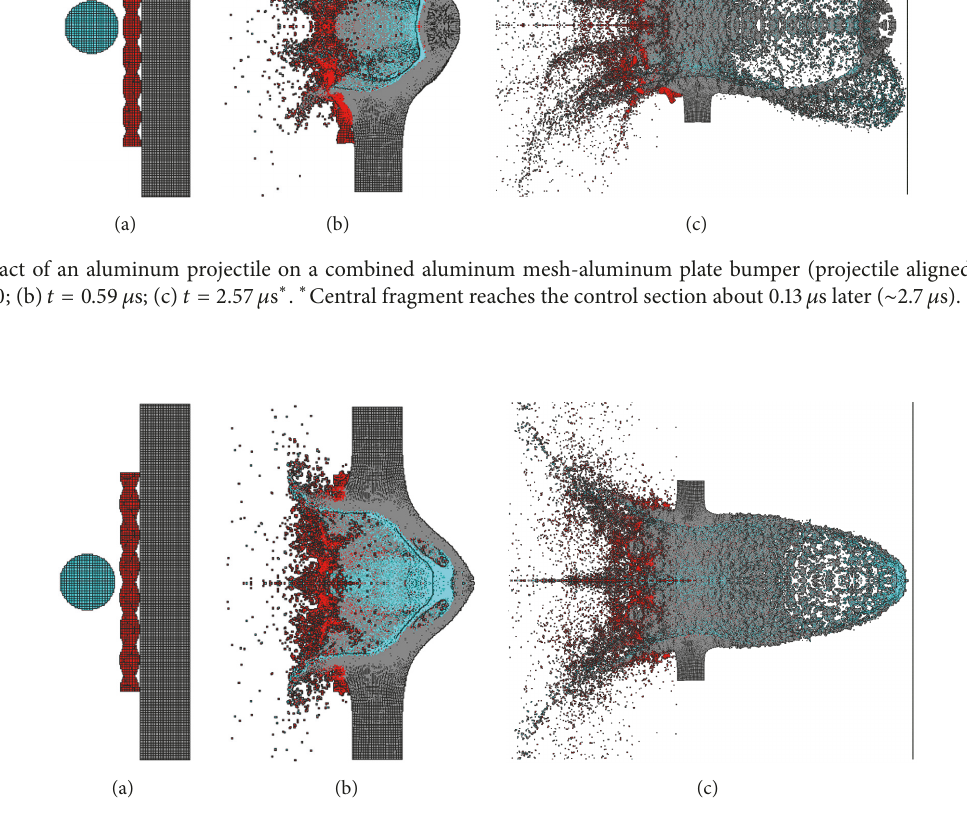
Figure 9: Impact of an aluminum projectile on a combined aluminum mesh-aluminum plate bumper (projectile aligned with aperture): (a) 𝑡 = 0 ; (b) 𝑡 = 0.55 𝜇 s; (c) 𝑡 = 2.01 𝜇 s.